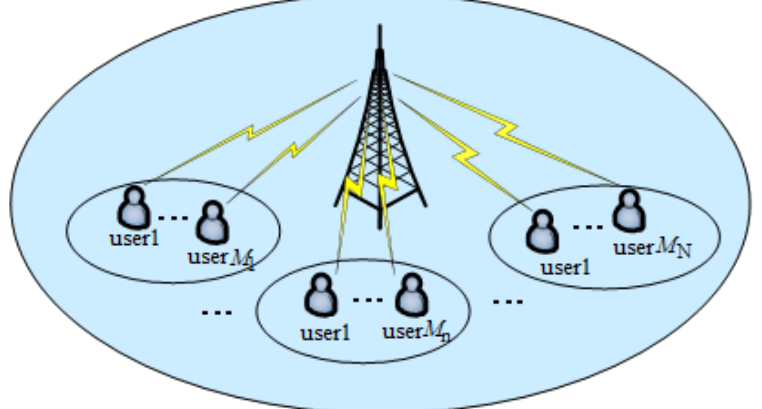
Figure 1. Downlink multicarrier NOMA system